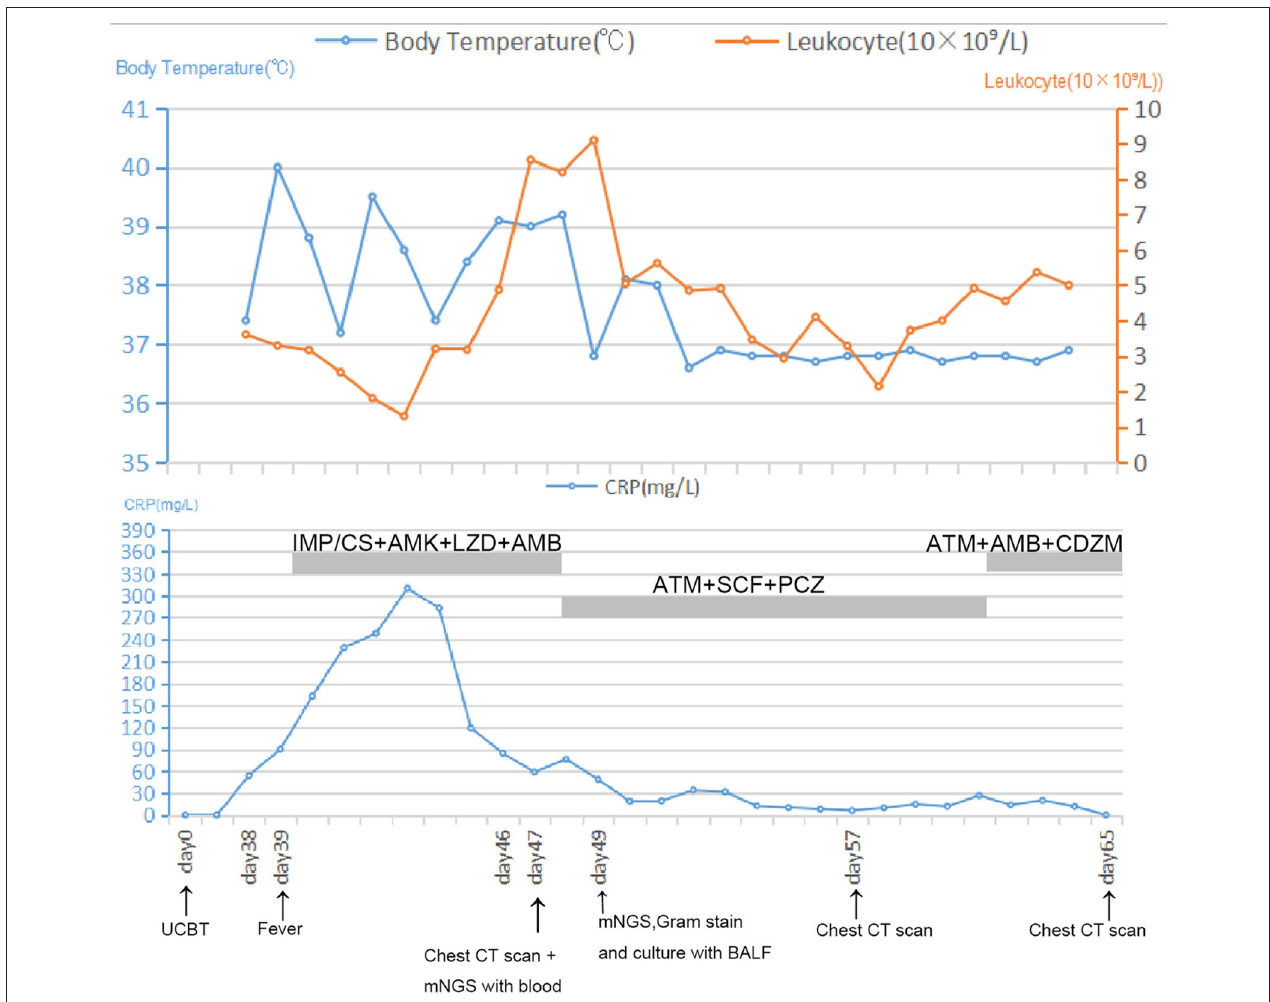
FIGURE 1 | Timeline with relevant data from the episode of care; body temperature curves, leukocyte counts, and CRP. Major events are indicated with arrows. Yellow line shows the leukocyte counts in peripheral blood. Blue line on the top shows body-temperature values. Blue line on the bottom shows CRP values. Horizontal thick gray lines show the medications administered: IMP/CS, Imipenem and cilastatin sodium; AMK, Amikacin; LZD, Linezolid; AMB, Amphotericin B; ATM, Azithromycin; SCF, Sulbactam and cefoperazone sodium; PCZ, Posaconazole; CDZM,